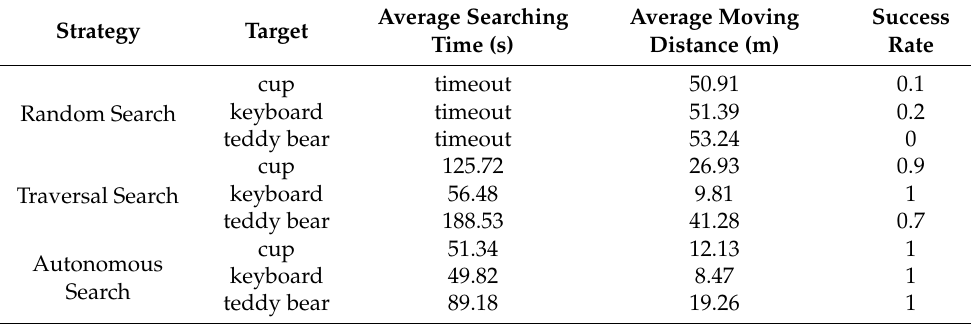
Table 2. The performance of different searching